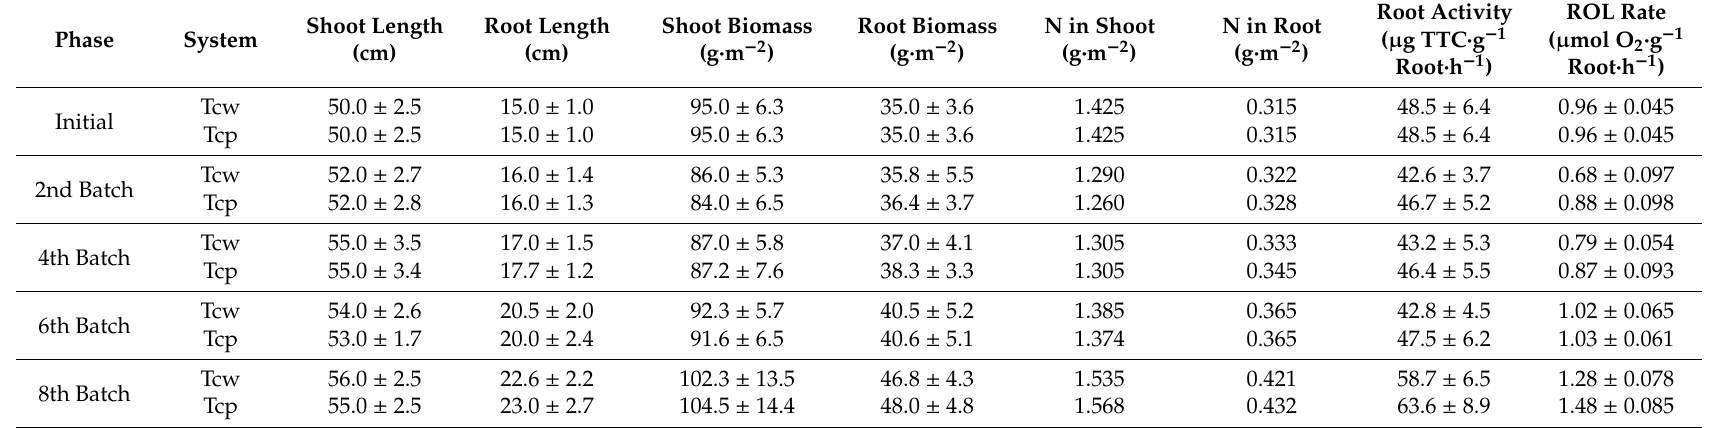
Table 2. Length, biomass, nitrogen content, root activity, and radial oxygen loss (ROL) rate in the plants (means ± SD., p < 0.05, n = 4). Shoot Phase System